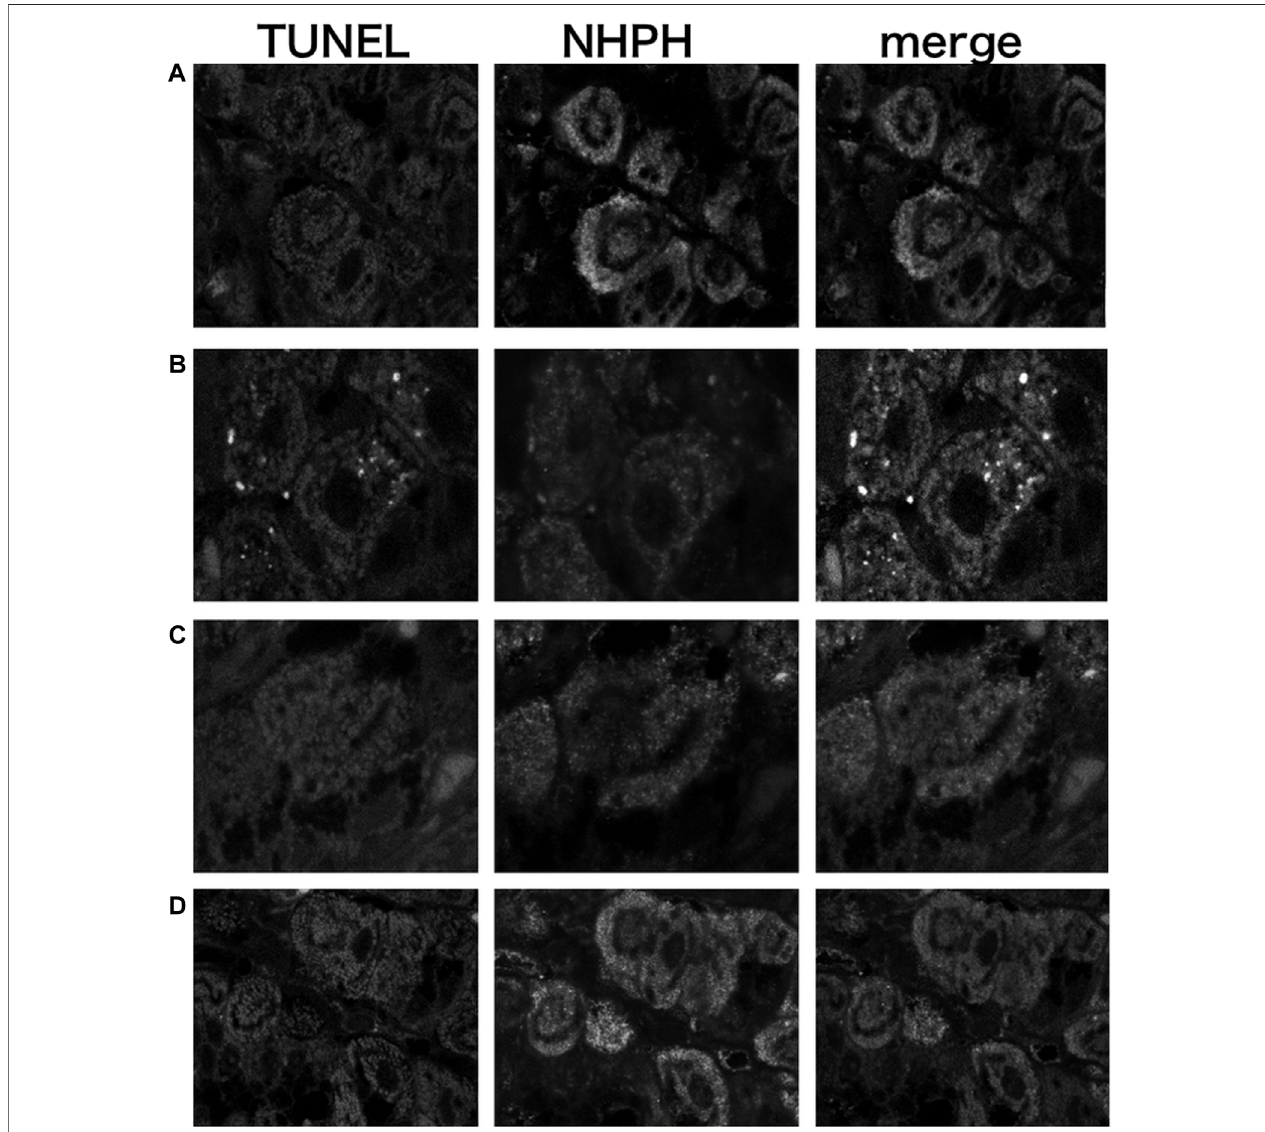
FIGURE 7 | Localization of apoptotic NHPHs in the infection group by acid suppressants by the TUNEL method X 200. (A) In the infection-alone group, no apoptosis was detected. (B) In the vonoprazan-treated group, apoptotic NHPHs were detected within the intracellular canaliculi of the parietal cells. (C) In the lansoprazole-treated group, many NHPHs were found, but no apoptotic reaction was recognized. (D) In the famotidine-treated group, NHPHs in the parietal cells were negative for the TUNEL reaction.